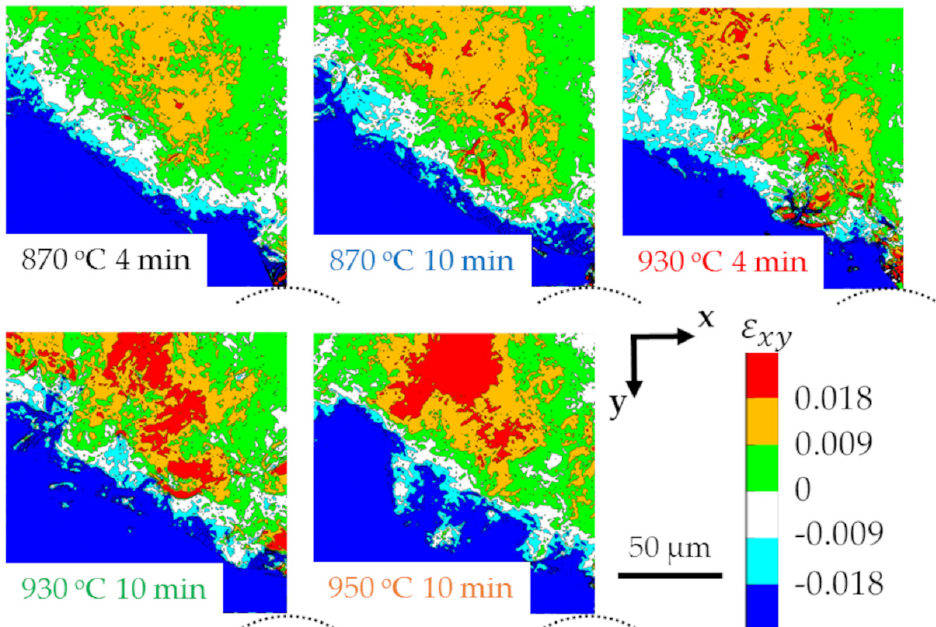
Figure 9. The distribution of shear strain, 𝜀 (cid:3051)(cid:3052) , in a 135-by-135 μ m 2 region close to the notch (marked in Figure 6a as ‘region of interest’) in the single-edge notch specimens of the five heat-treated martensitic steel deformed to a macroscopic normalized extension, 𝛿/𝐿 (cid:2868) , of 0.05 ± 0.003. The loading direction is along the x-axis and the dotted arcs mark the initial location of the notch tip.